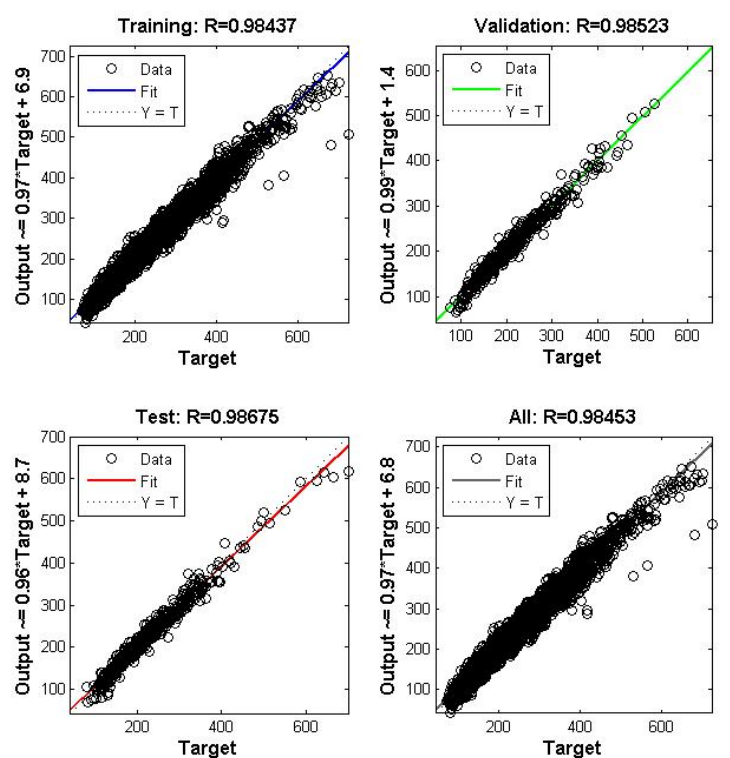
Figure 3. Absolute errors of the developed BP ANN model.